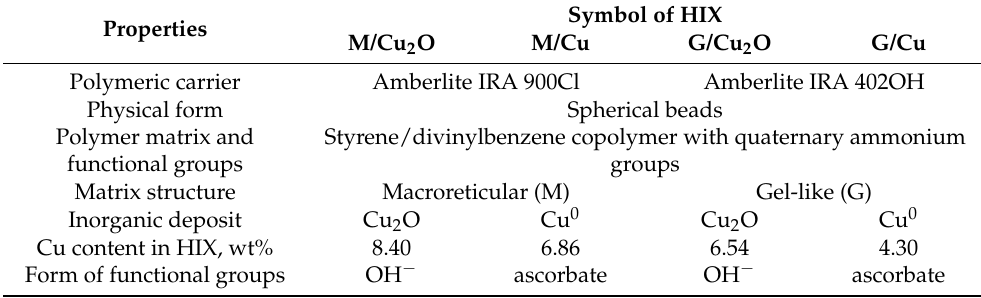
Table 1. Materials used for